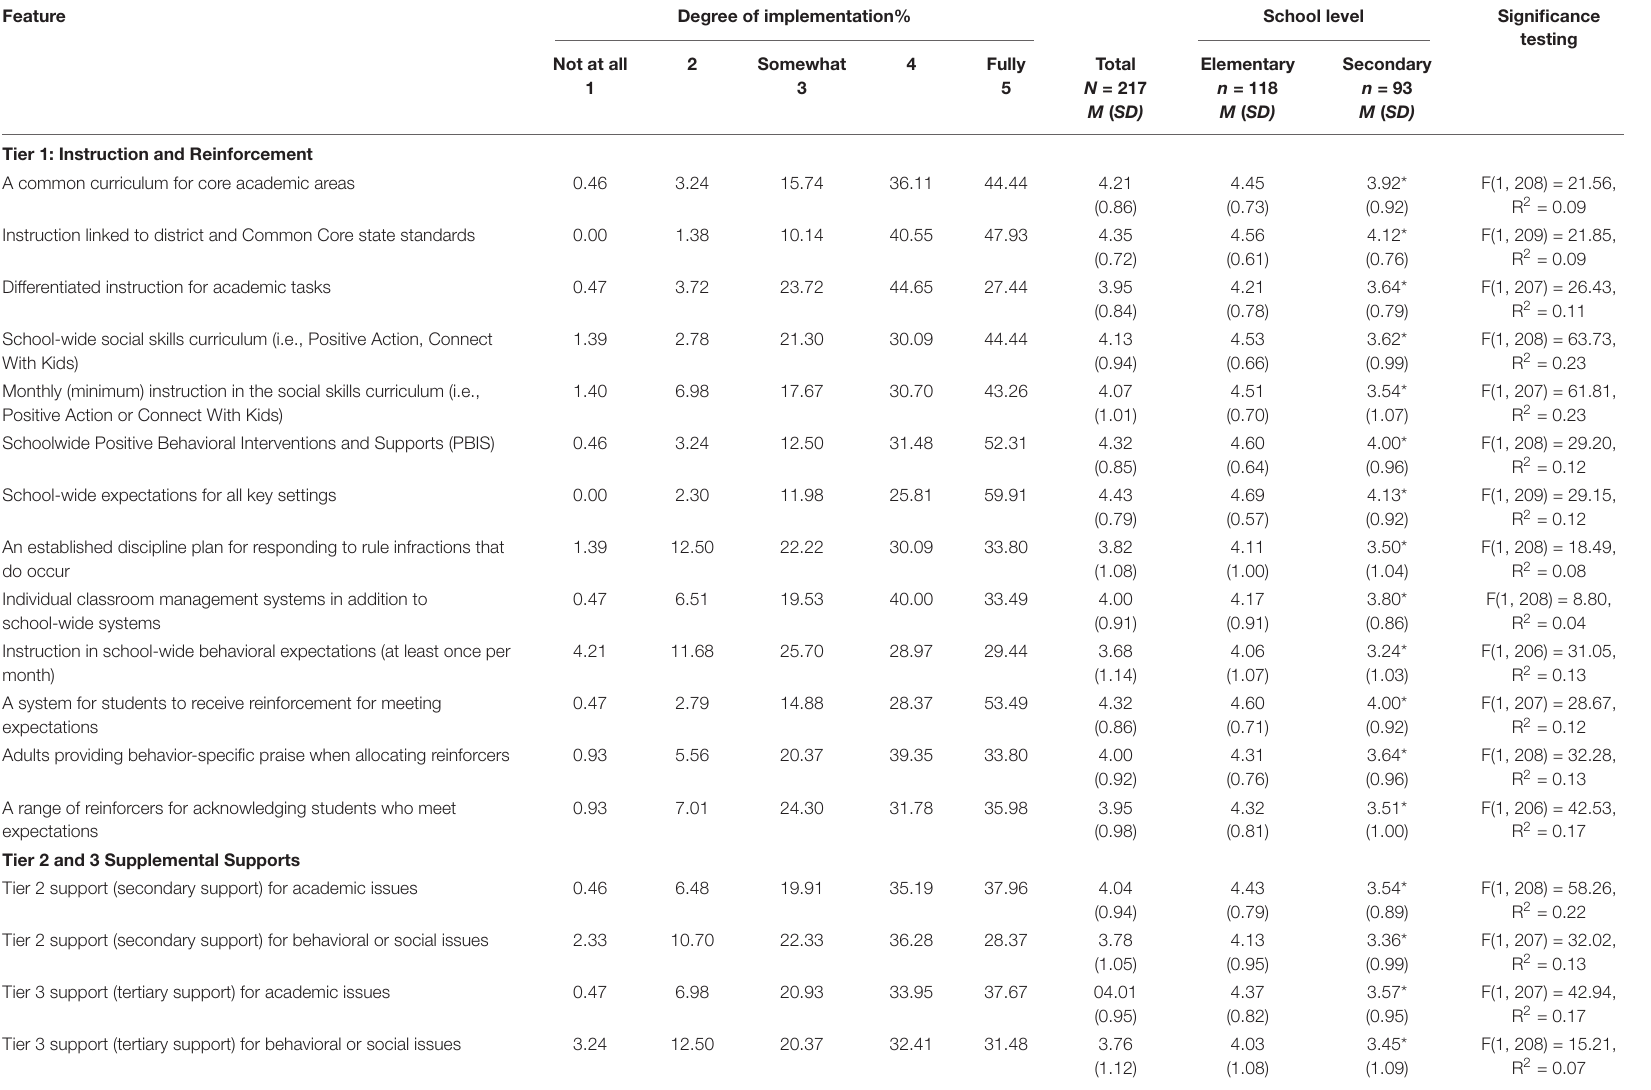
TABLE 2 | Ratings of features of three-tiered models currently being implemented.